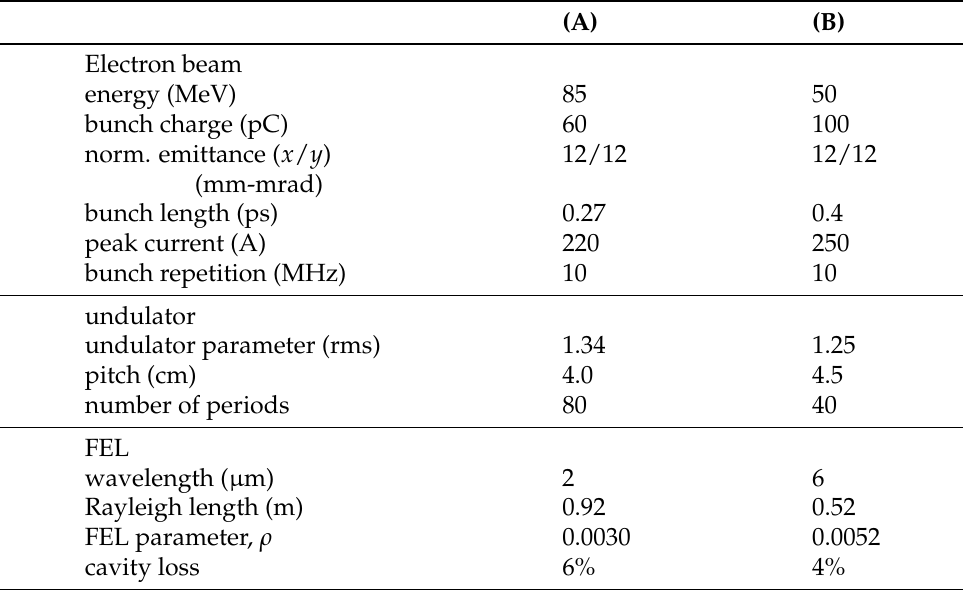
Figure 13. Schematic view of high-harmonics generation driven by an infrared FEL oscillator (FEL-HHG). Table 2. Example parameters of FEL oscillators for